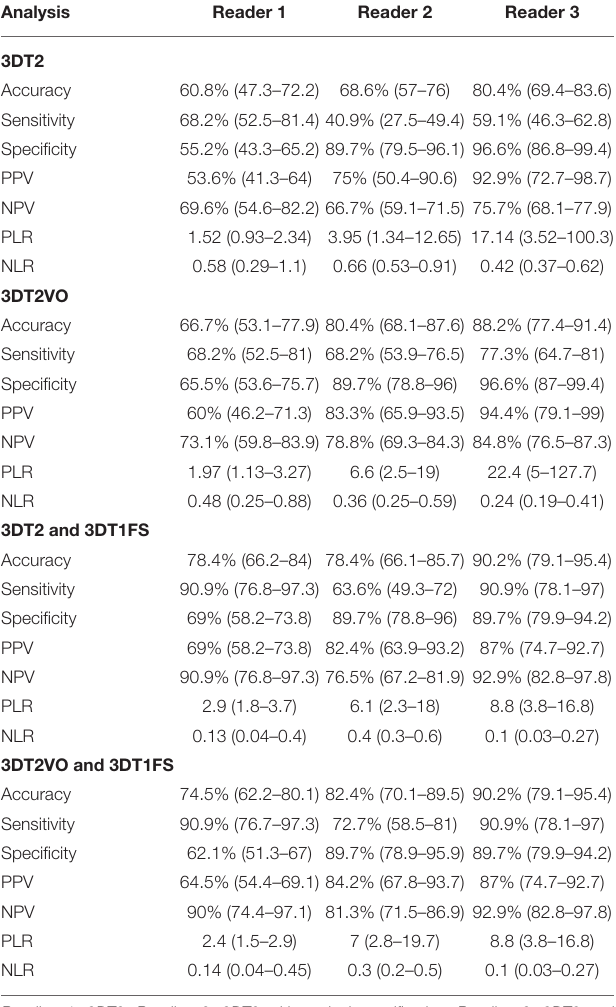
TABLE 2 | Overall accuracy of MRI in the diagnosis of vaginal endometriosis per reader.